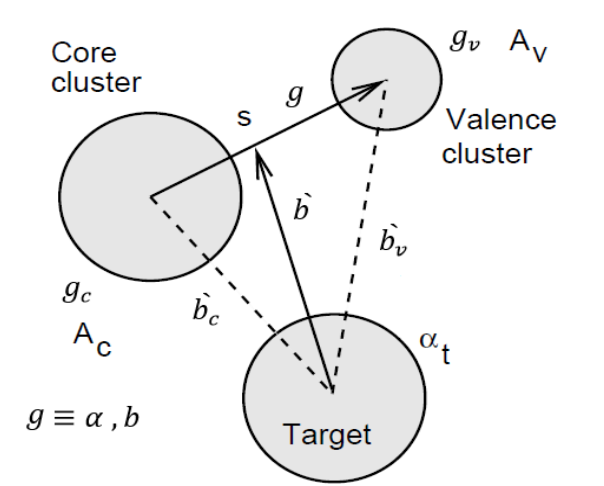
Fig.1: The coordinates of the target and two-cluster projectile